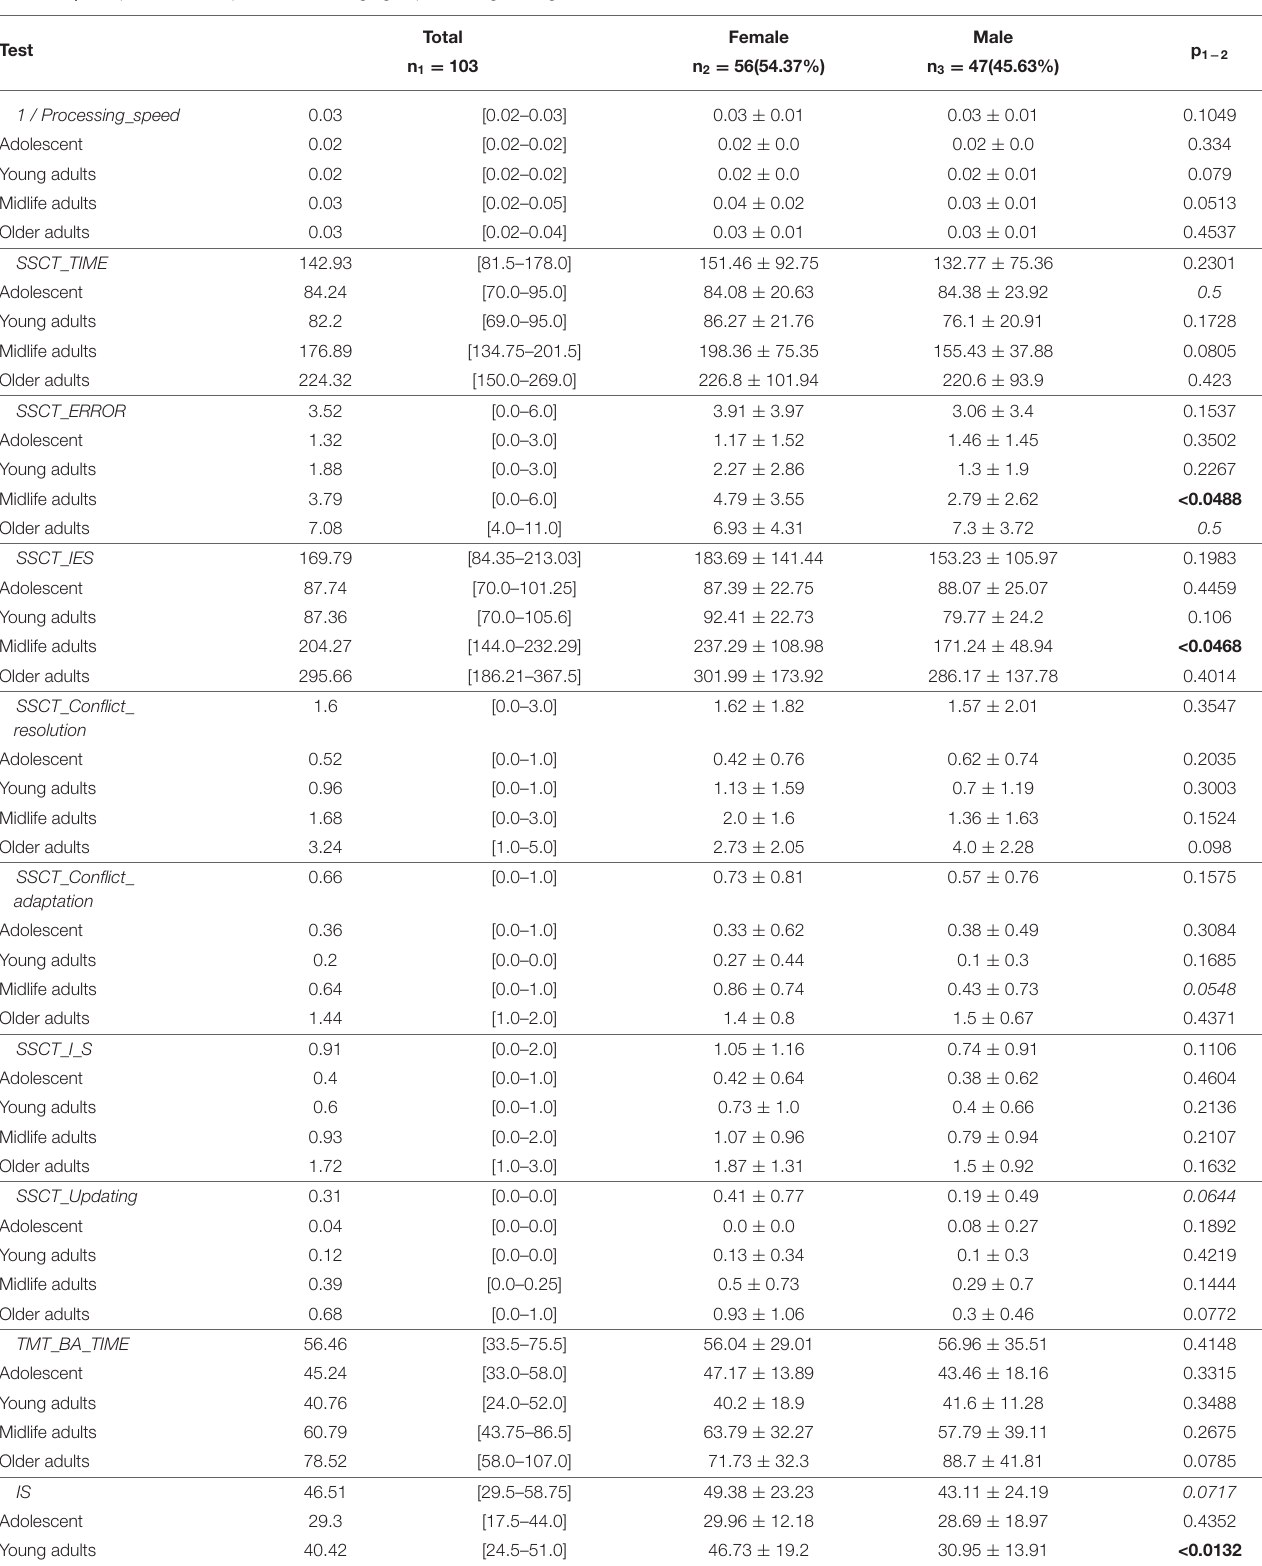
TABLE 4 | Comparison of test performance in age groups with regard to gender in SSCT